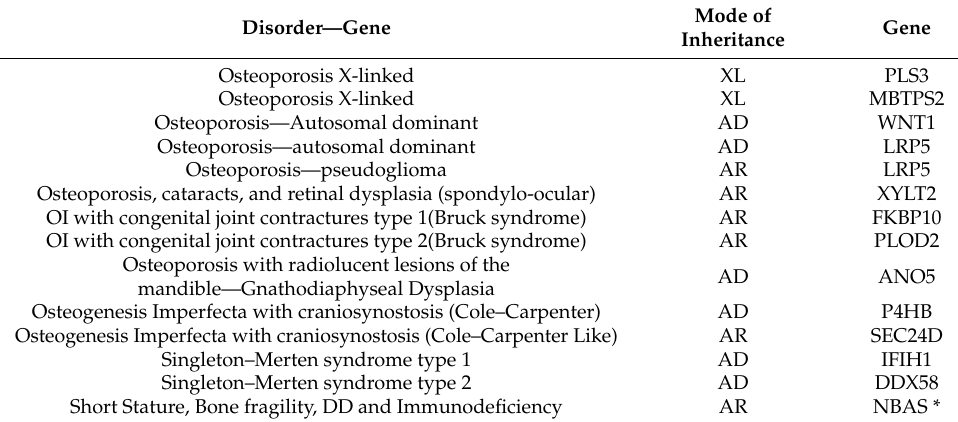
Table 9. Familial Osteoporosis and Special Syndromes with Phenotypic features overlapping